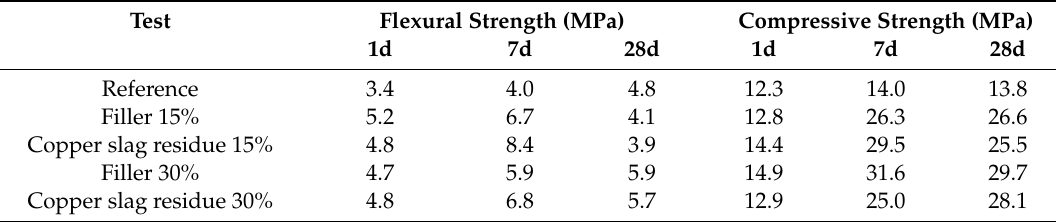
Table 8. Mechanical strength of mortars containing copper slag bioleach residue as SCM. Each value is an average of 2 values for the flexural strength and of 4 values for the compressive